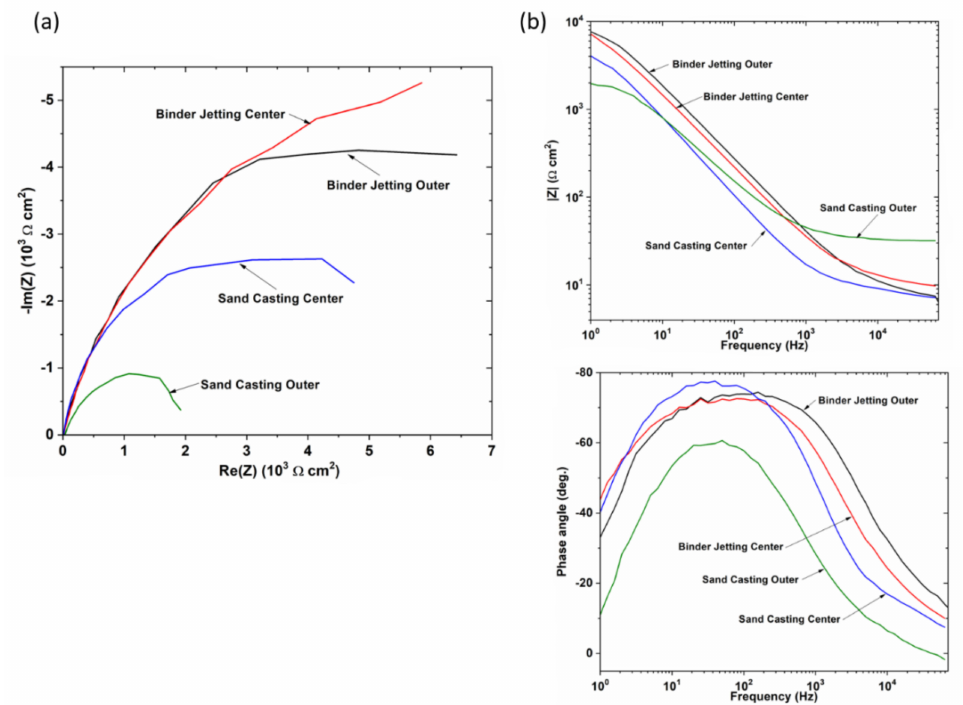
Figure 9. Nyquist ( a ) and Bode ( b ) plots of binder jetting and sand casting samples in 3.5% NaCl, center and outer